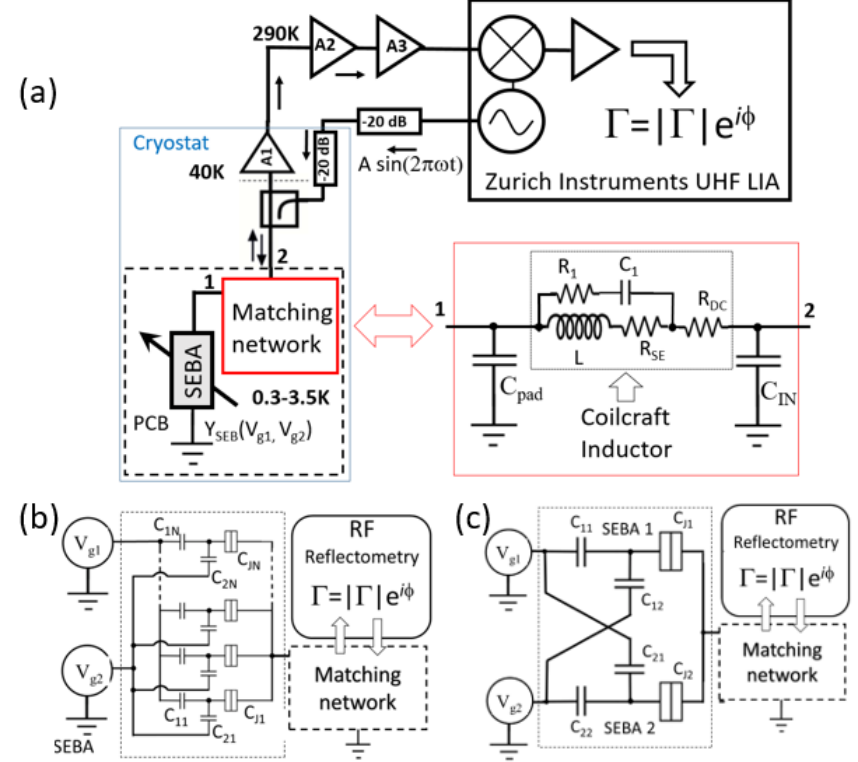
Figure 4. ( a ) Simplified circuit diagram of the single-port reflectometry setup. Circuit delineated by a dashed line is the sample attached to the PCB board with the MN and cooled to a temperature defined by the setup; the MN circuitry is outlined in a red box with port 1 facing the sample and port 2 facing the directional coupler. Blue rectangle delineates the cryogenic part of the measurement apparatus. Amplifier at 40 K, ZX60-P33ULN + is thermally anchored to the 1st stage of the cryocooler, T ≈ 40 K; two stage amplifier at room temperature uses ZX60-P103LN + ; both types of amplifiers are by Mini-Circuits. Directional coupler ZFDC-20-50-S + and cold attenuator are located at the second stage of cryocooler @2.7 K (Janis He3, Bluefors) or 3.5 K (ARS). The PCB with the sample is bolted to the He3 pot (Janis He3); mixing chamber sample exchange platform (Bluefors) or 2nd stage of cryocooler (ARS). ( b ) Block diagram of the experiment with a SEB array coupled to two gates with capacitances C 11 ... C 1 n to V g 1 (“sensing gate”) and C 21 ... C 2 n to V g 2 (“tuning gate”). ( c ) Block diagram of the experiment for comparative measurements of two arrays. The junction sides of the SEBs for both arrays are connected to the same MN. For simplicity each array is shown as a single SEB. The devices are spatially separated on the chip to minimize capacitive crosstalk.